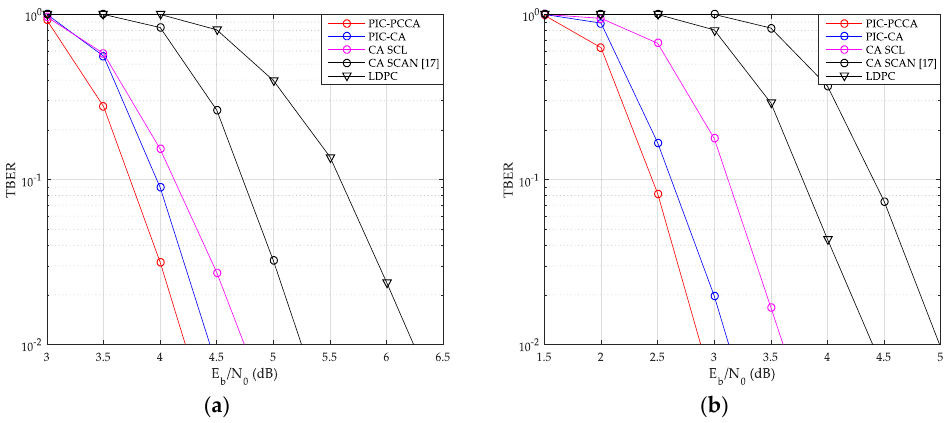
Figure 15. TB error rate (TBER) of SCMA over AWGN channel. ( a ) K = 100, R = 1/2; ( b ) K = 64, R = 1/3.